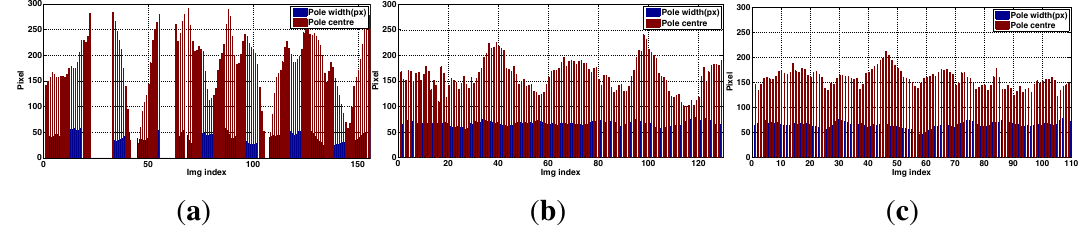
Figure 38. Experimental results for circumnavigation: pole width (blue) and offset of the pole centre from the image edge (red) versus time. Comparison of Pilot 2 manual flight ( a ), and Pilot 1 shared autonomy flights using IBVS and PBVS ( b , c respectively). Since the image width is 320 pixels, a value of 160 for “Pole centre” indicates the pole was centred in the image. Zero values are for frames where the pole didn’t appear in the image. ( a ) Pilot 2; ( b ) IBVS; ( c )